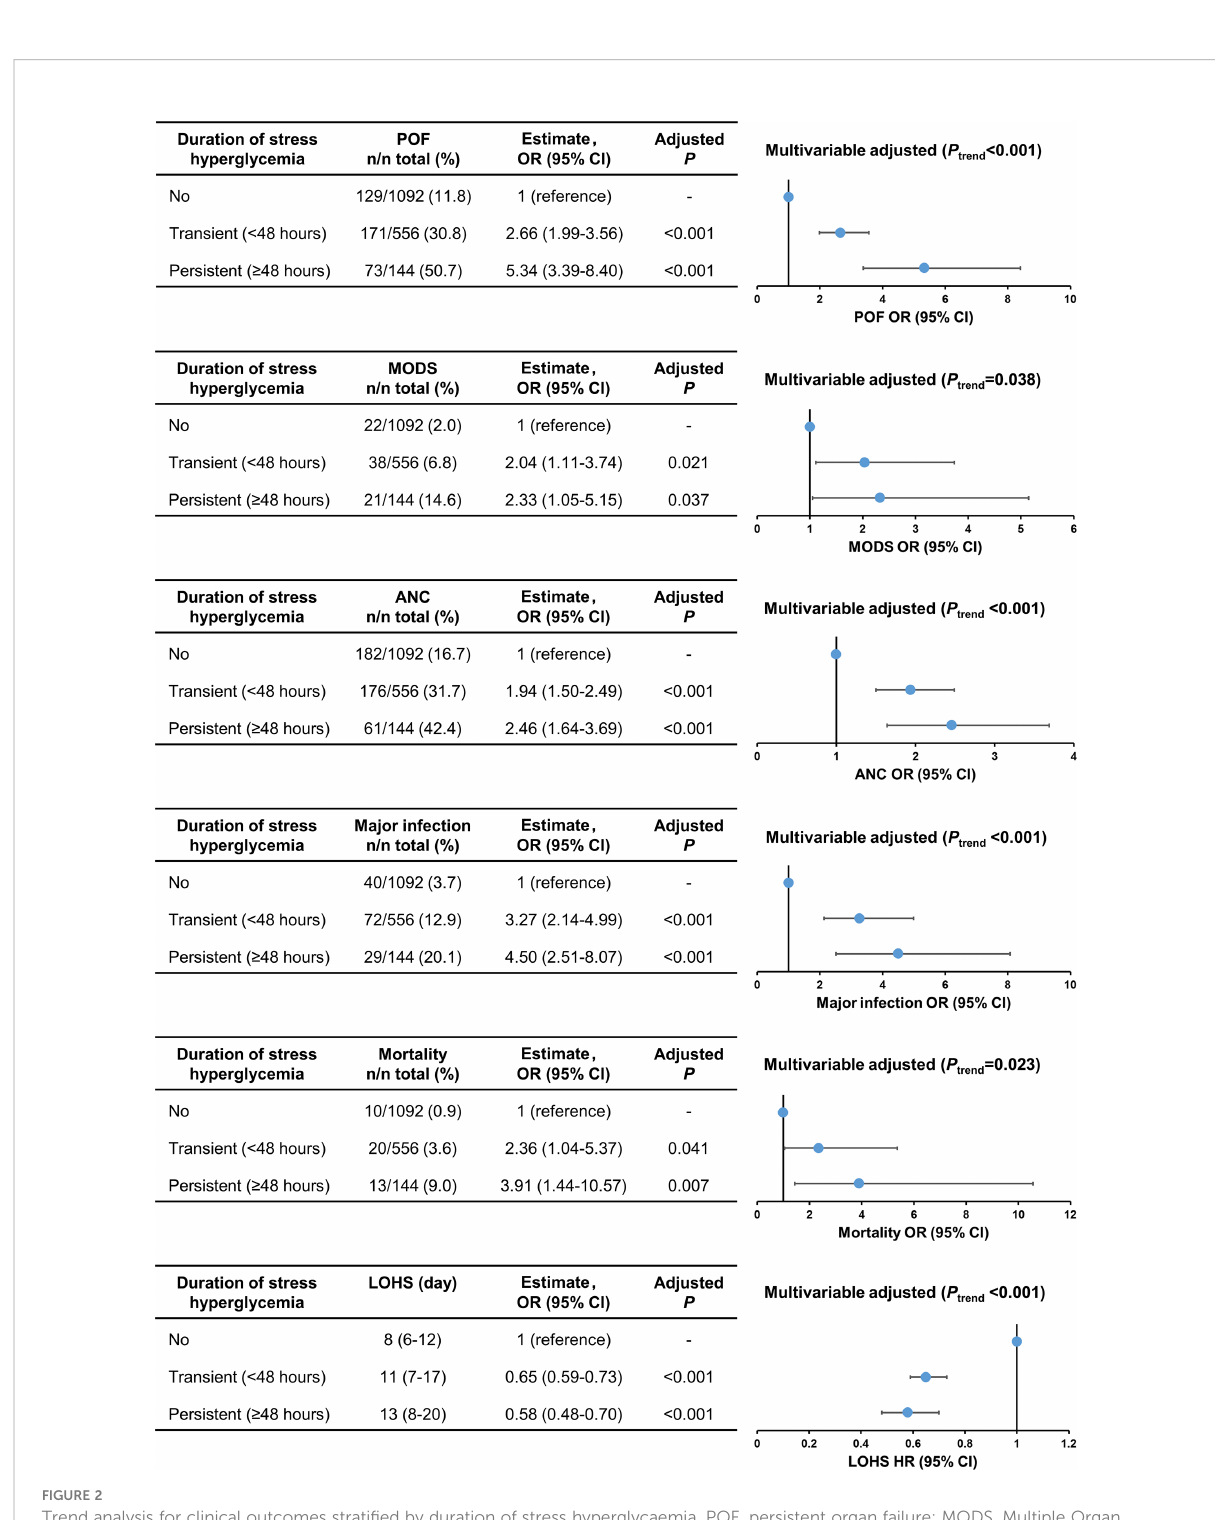
FIGURE 2 Trend analysis for clinical outcomes strati fi ed by duration of stress hyperglycaemia. POF, persistent organ failure; MODS, Multiple Organ Dysfunction Syndrome; ANC, acute necrotic collection; LOHS, length of hospital